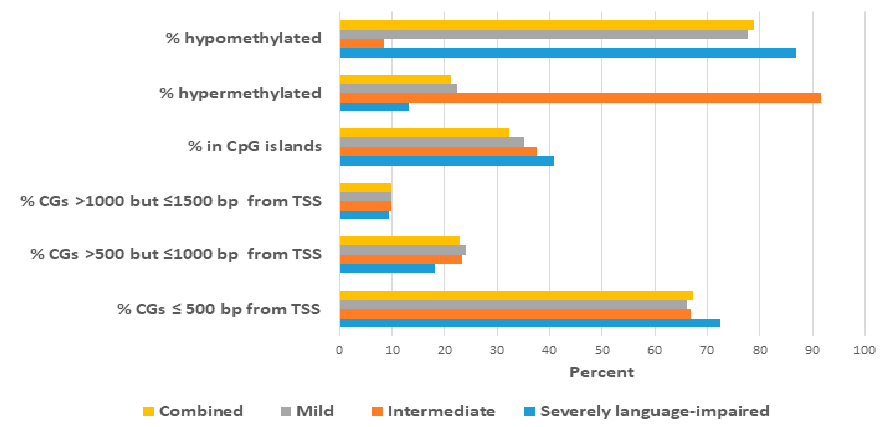
Figure 3. Summary of the proportions of differentially methylated CpG sites at different distances relative to the transcription start site (TSS) of the closest gene and the proportion of hypermethylated and hypomethylated sites in each ASD case group.